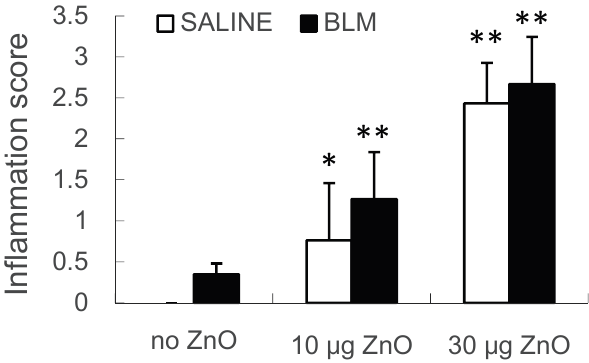
Figure 2. The results of histological scoring for total lung inflammation. Mice were exposed to ZnO nanoparticles with or without BLM treatment. Total lung inflammation at Day 10 after administration was defined using H&E staining of lung tissue. The number of mice was six in the SALINE-no ZnO, seven in the SALINE-10 µg of ZnO, six in the SALINE-30 µg of ZnO, six in the BLM-no ZnO, six in the BLM-10 µg of ZnO and seven in the BLM-30 µg of ZnO group. Data are the mean ± SD; * p < 0.05; ** p < 0.01; compared to the vehicle